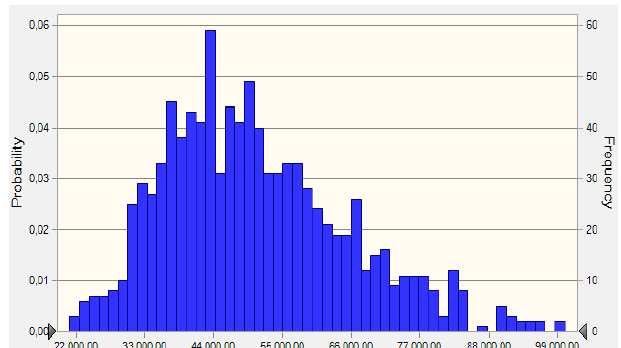
Figure 9. Probability distribution of present values of incomes from accommodation rental facilities during 10 years in Bratislava.